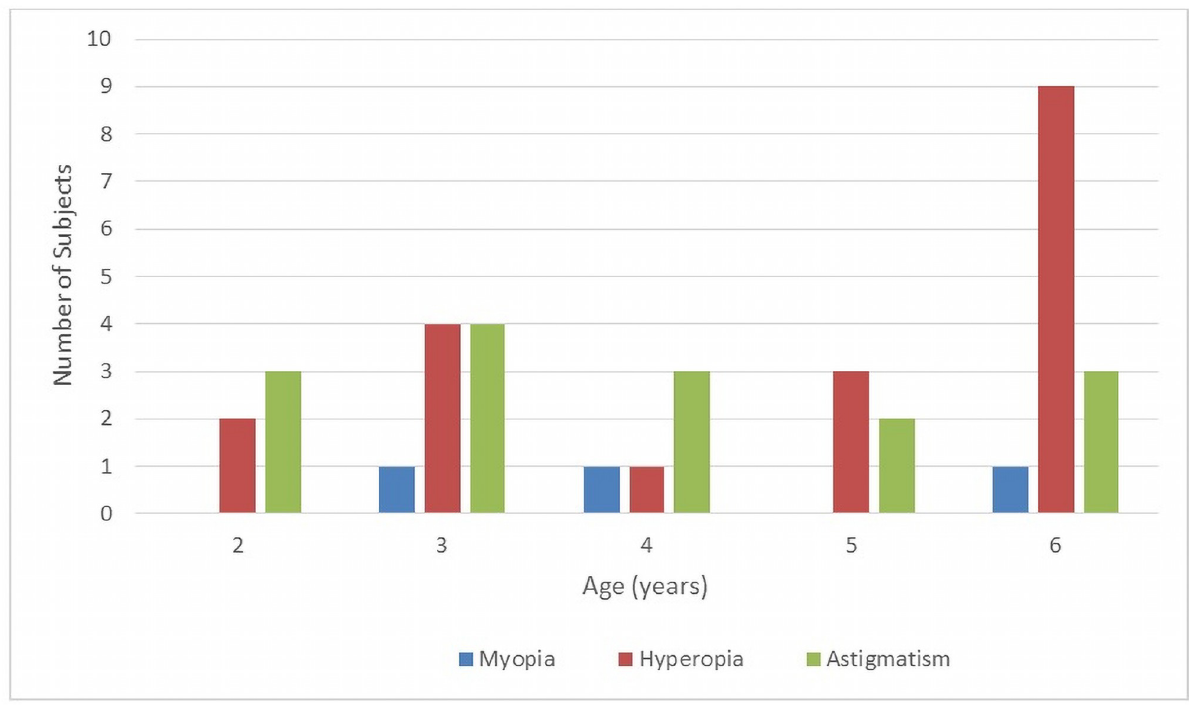
Fig 2. The distribution of refractive errors according to age in the examined